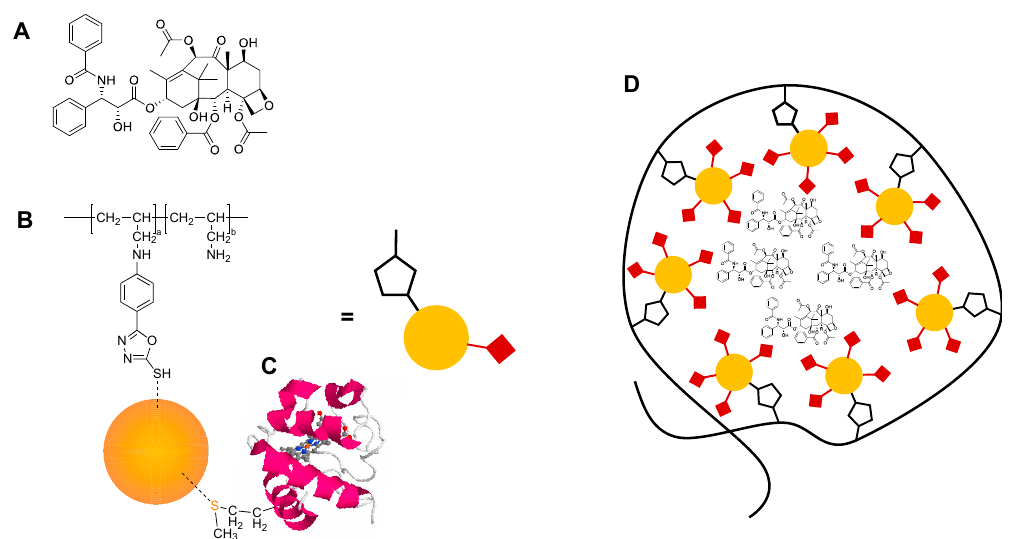
Figure 1. Chemical structure of ( A ) paclitaxel and ( B ) poly(allylamine)-oxadiazole (PAA-Ox5)-hybrid iron oxide-gold nanoparticle (HNP), and molecular structure of ( C ) cytochrome C and ( D ) novel formulation.